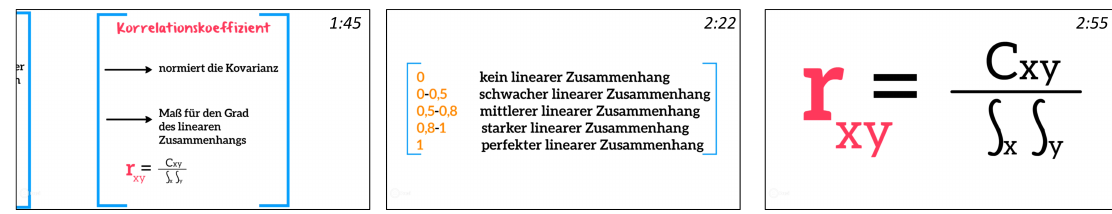
Figure 6. Three successive presentation frames from Video 2 (with added timestamps) showing loss of visual context between Frame 1 and Frame